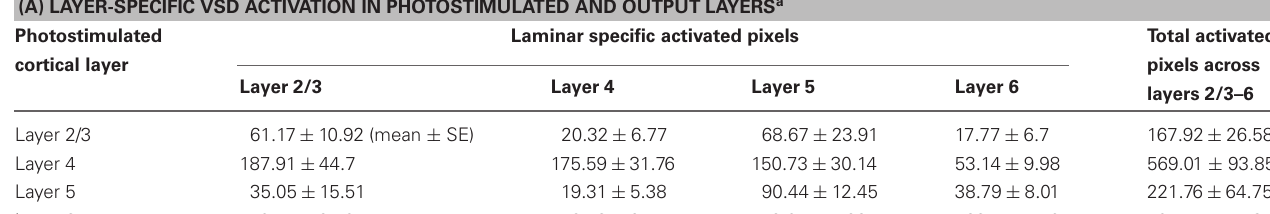
Table 1 | VSD activation in response to laminar specific photostimulation, and interlaminar functional projection strength in normal ACSF. (A) LAYER-SPECIFIC VSD ACTIVATION IN PHOTOSTIMULATED AND OUTPUT LAYERS